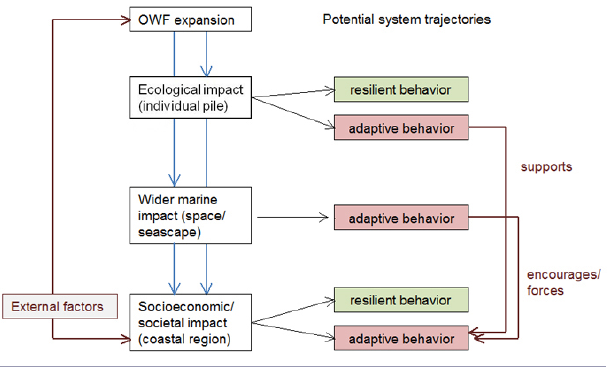
Fig. 9 . Dynamic conceptual model illustrating the linkages between the offshore wind farm (OWF) case study and the potential future system